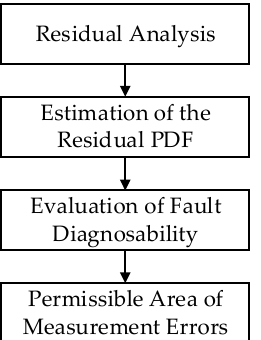
Figure 3. Schematic diagram of permissible area of measurement errors.